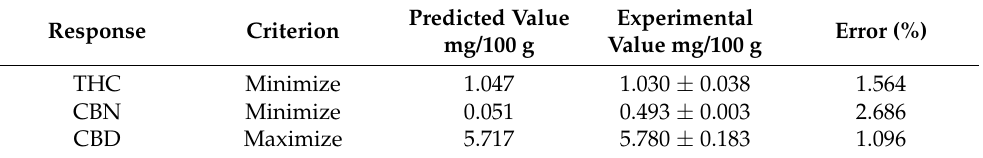
Table 8. The experimental and predicted values for optimal in situ decarboxylation conditions. Response